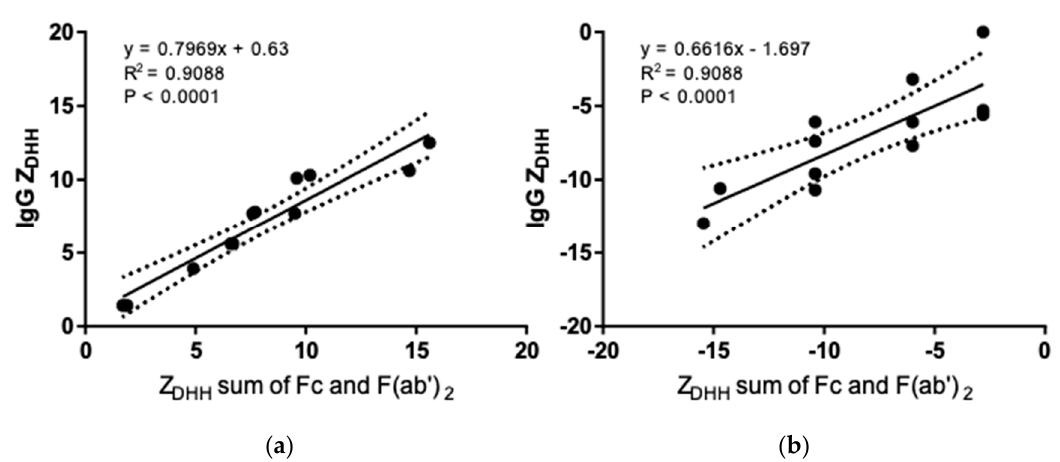
Figure 7. Linear regression analysis and correlation between Z DHH measured from intact IgG and the sum of Z DHH from the fragments. ( a ) pH 5.0 acetate. ( b ) pH 7.4 PBS. Dotted lines indicate the 95% confidence interval.